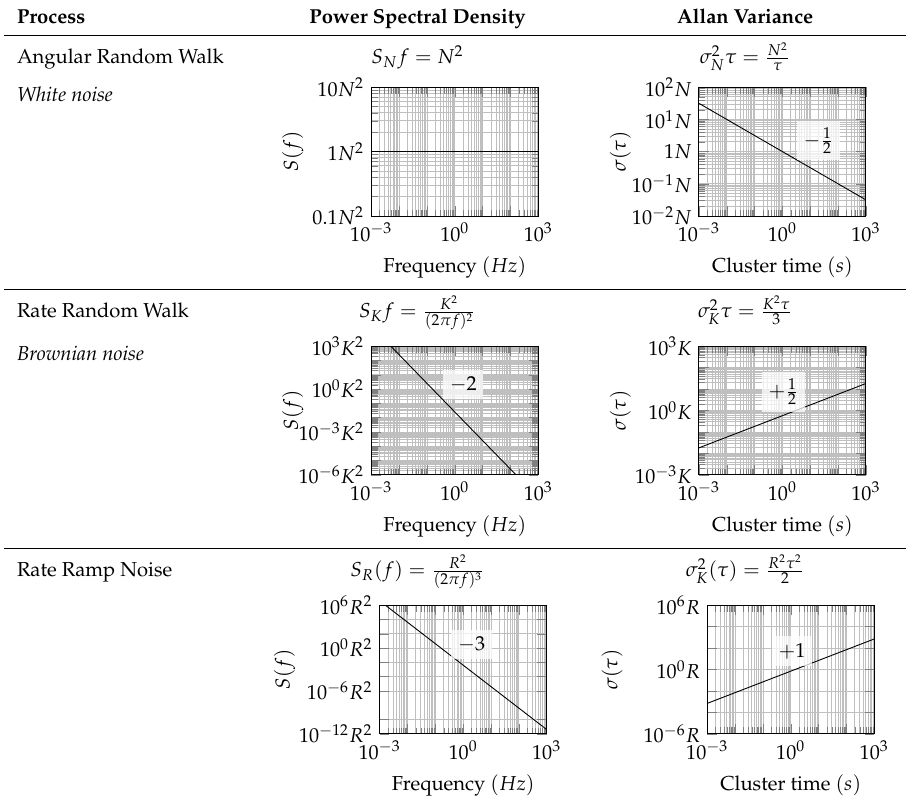
Table A3. Power spectral density and Allan variance of typical inertial sensor noise processes